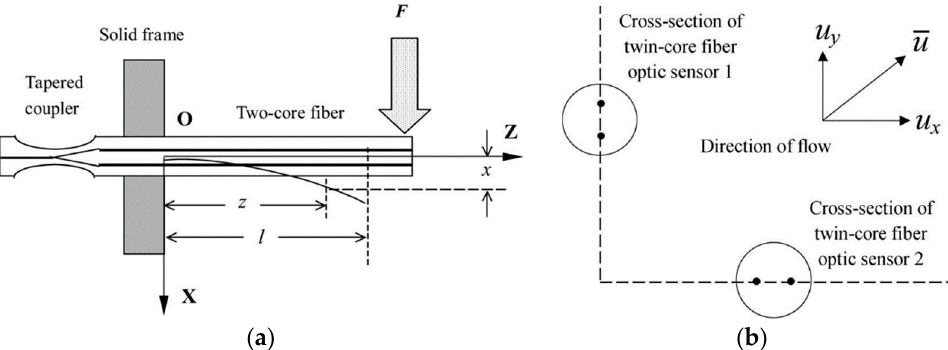
Figure 10. ( a ) Experimental setup of the dual ‐ core ‐ fiber ‐ based Michelson interferometer bending sensor. The inset shows the bent dual ‐ core fiber [19]. ( b ) The schematics of the arrangement of the two dual ‐ core fibers for a vector flow velocity sensor [22].